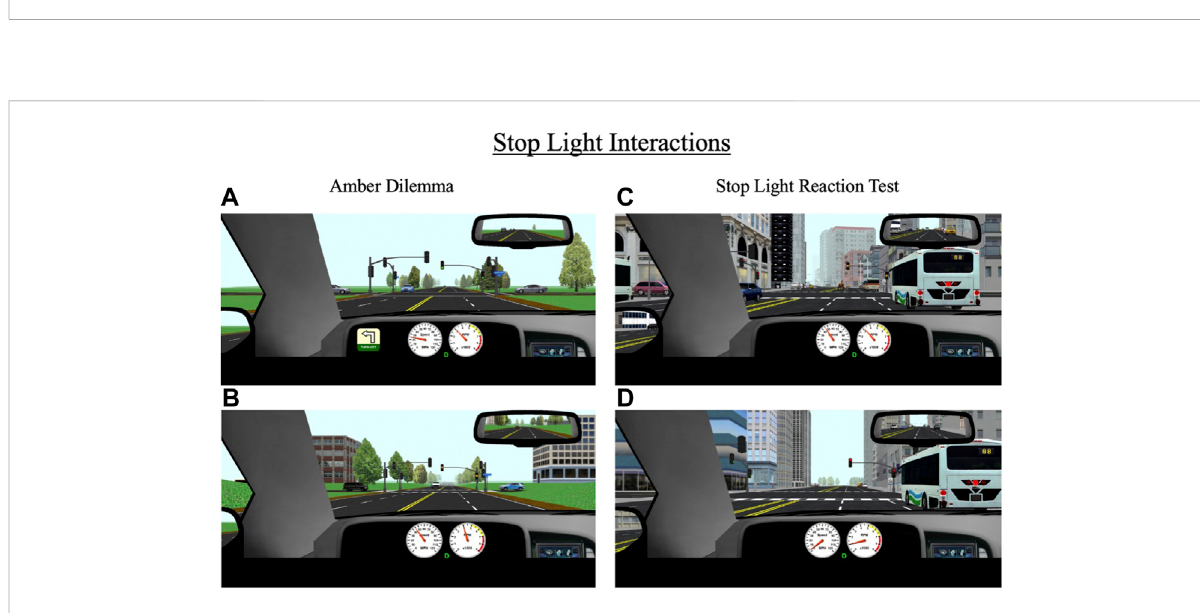
FIGURE 6 Stop light interactions for (A,B) amber dilemmas and (C,D) stop light reaction test that occur throughout the drive in rural and urban environments. During amber dilemmas, participants will approach a green light (A) that will change to yellow (B) 3.5 s from the intersection. During the stop light reaction test, participants will approach a green light that will change to yellow (C) 5.5 s from the intersection and then to red (D) 3.5 s after the yellow transition. The primary outcomes for these events are response to the traf fi c signal (i.e., stop or go through the light), reaction time to the signal light, and if participants stop, their response time to a green signal